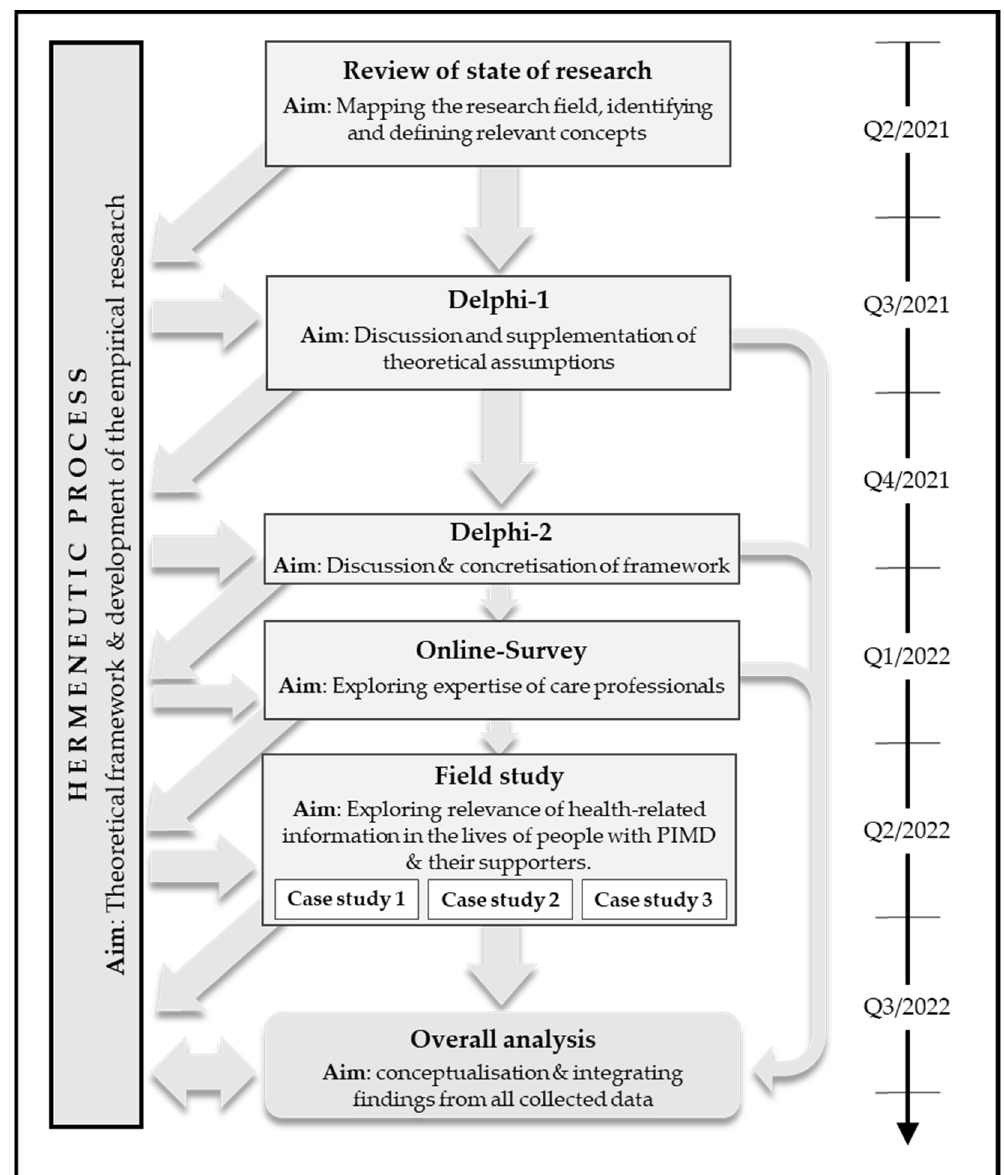
Figure 1. Visualisation of the research process.